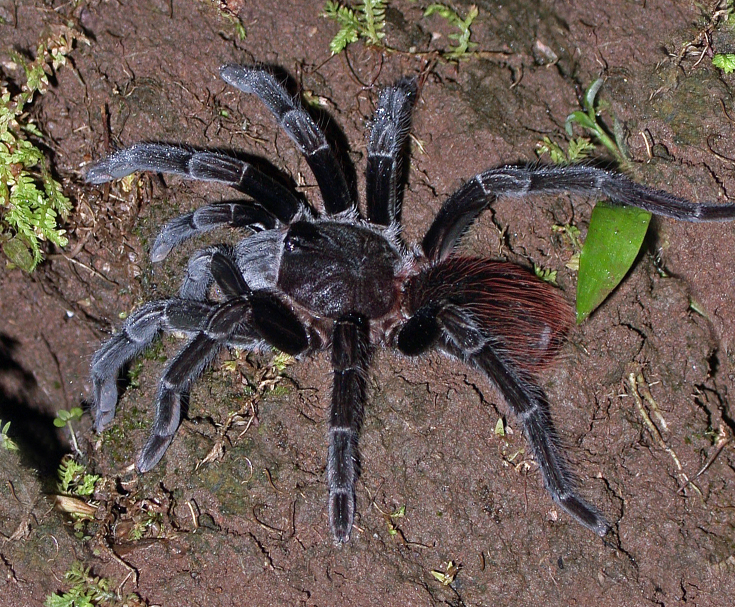
Sericopelma
embrithes (Chamberlin & Ivie, 1936) female from Barro Colorado Island, Panama province, Panama. Photo: Neville Winchester.